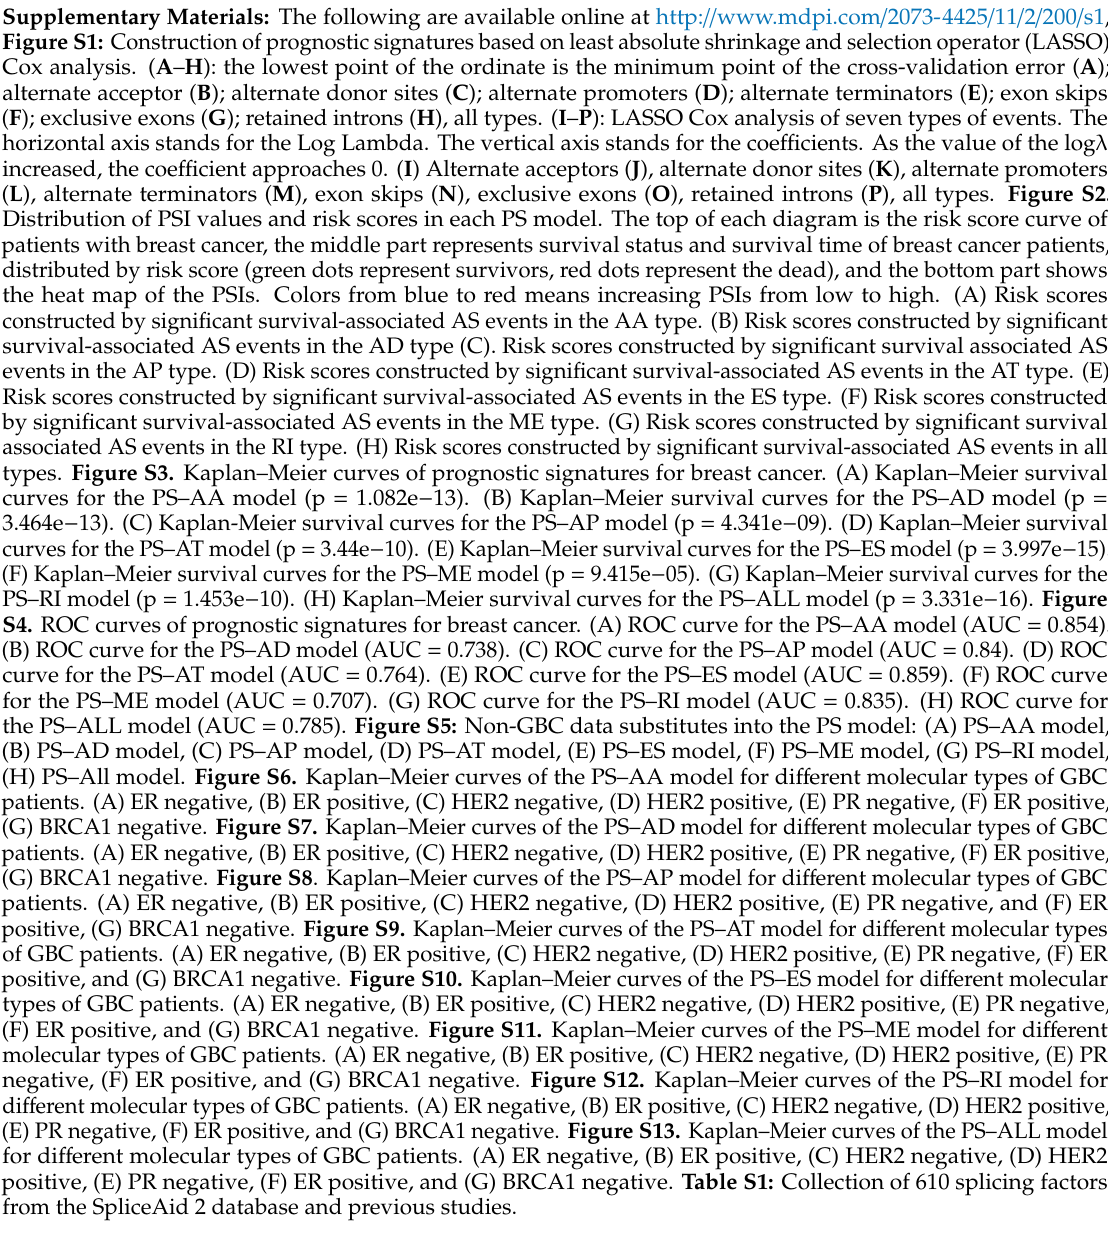
molecular types of GBC patients. (A) ER negative, (B) ER positive, (C) HER2 negative, (D) HER2 positive, (E) PR negative, (F) ER positive, and (G) BRCA1 negative. Figure S12. Kaplan–Meier curves of the PS–RI model for di ff erent molecular types of GBC patients. (A) ER negative, (B) ER positive, (C) HER2 negative, (D) HER2 positive, (E) PR negative, (F) ER positive, and (G) BRCA1 negative. Figure S13. Kaplan–Meier curves of the PS–ALL model for di ff erent molecular types of GBC patients. (A) ER negative, (B) ER positive, (C) HER2 negative, (D) HER2 positive, (E) PR negative, (F) ER positive, and (G) BRCA1 negative. Table S1: Collection of 610 splicing factors from the SpliceAid 2 database and previous